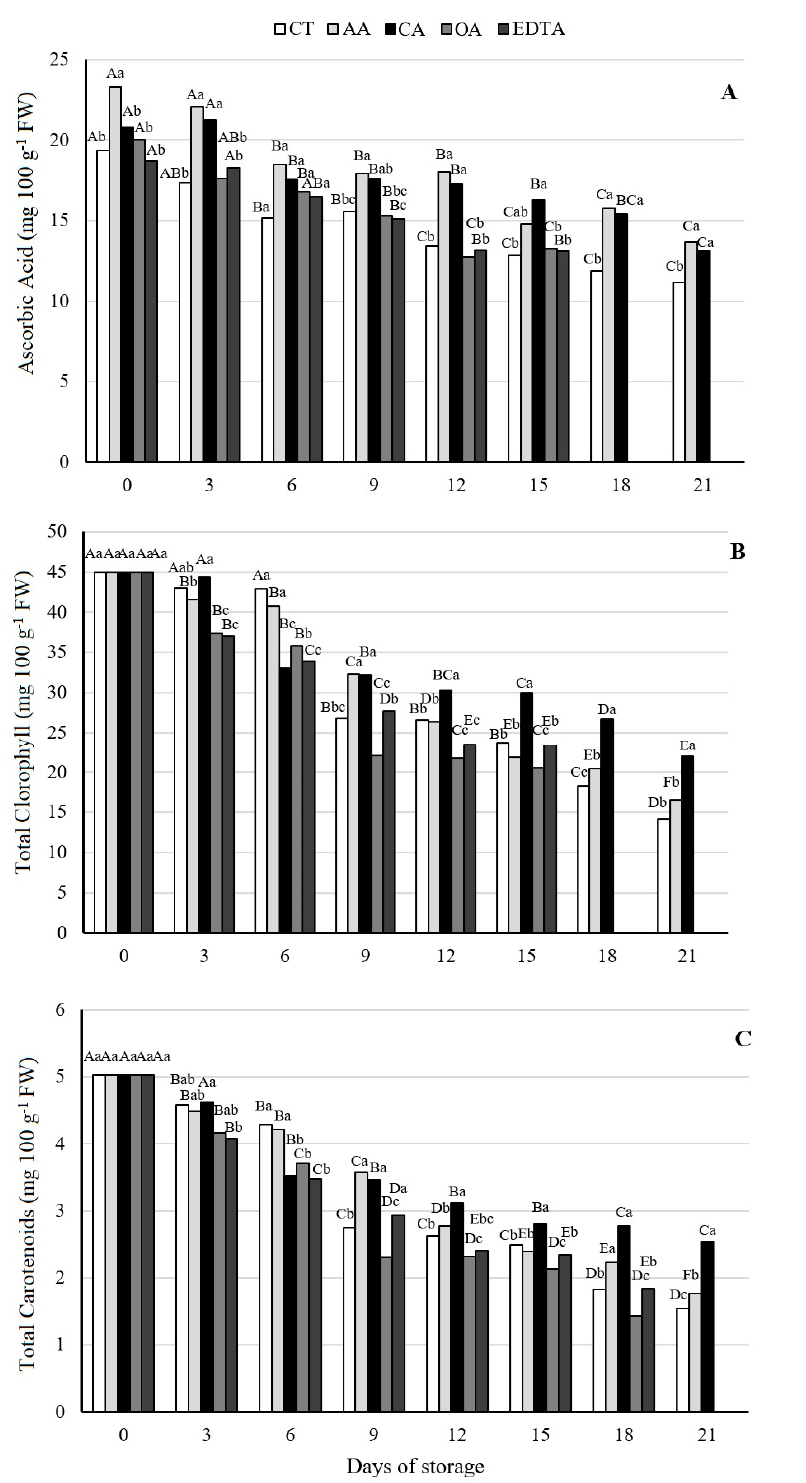
Figure 3. Ascorbic acid content (mg 100 g − 1 FW) ( A ), total chlorophyll (mg 100 g − 1 FW) ( B ), and total carotenoids (mg 100 g − 1 FW) ( C ) in minimally-processed escarole, treated with antioxidants and stored at 0 °C and 90–95% relative humidity, for 21 days. The columns represent the average of three replicates. Means followed by different uppercase letters within each day of storage and lowercase letters between treatments differ from each other by Tukey’s test ( P ≤ 0.01). CT: control; AA: 1% ascorbic acid; CA: 1% citric acid; OA: 1% oxalic acid; and 2% EDTA: ethylenediaminetetraacetic acid.